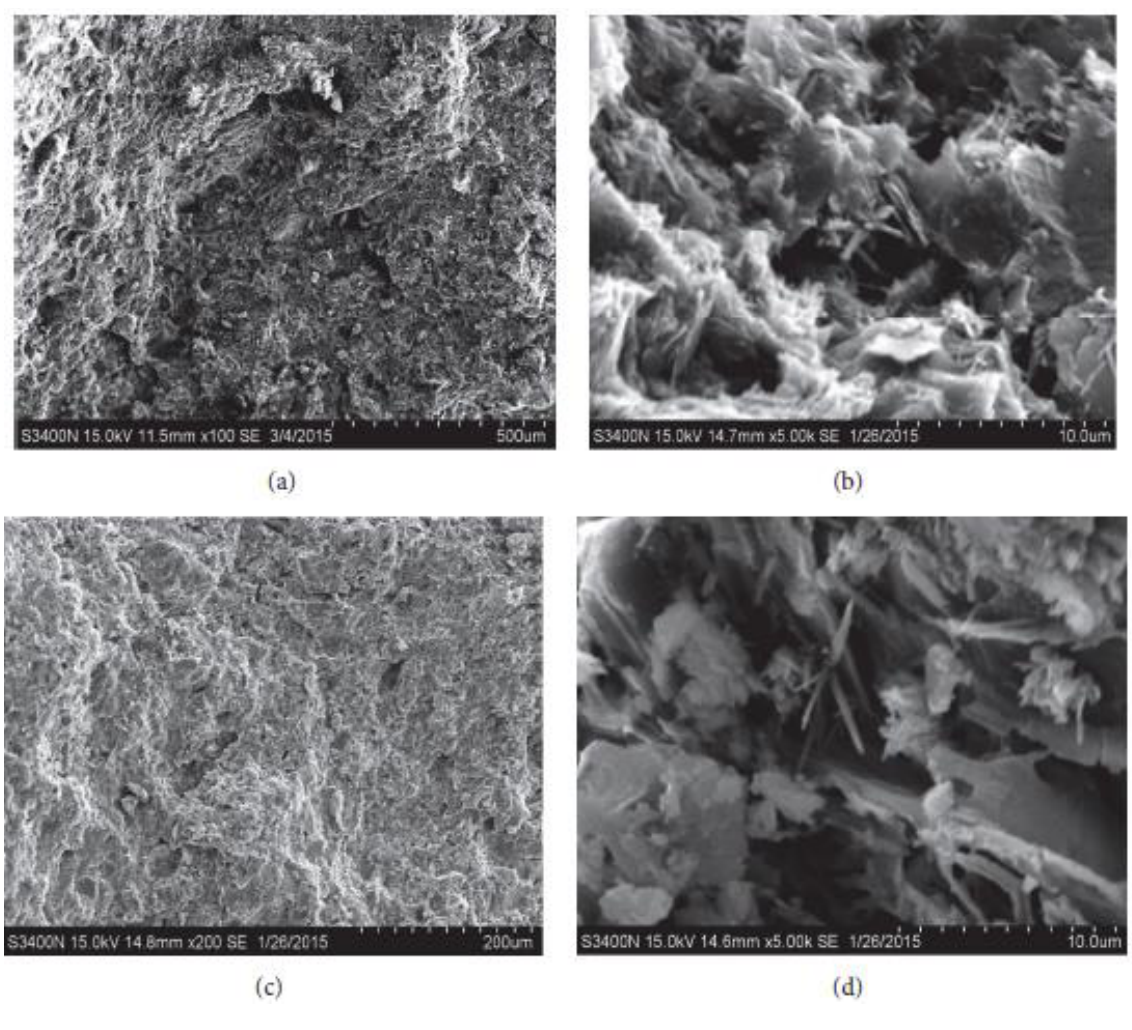
Figure 15. SEM Results ( a , b ) 7 days and ( c , d ) 28 days